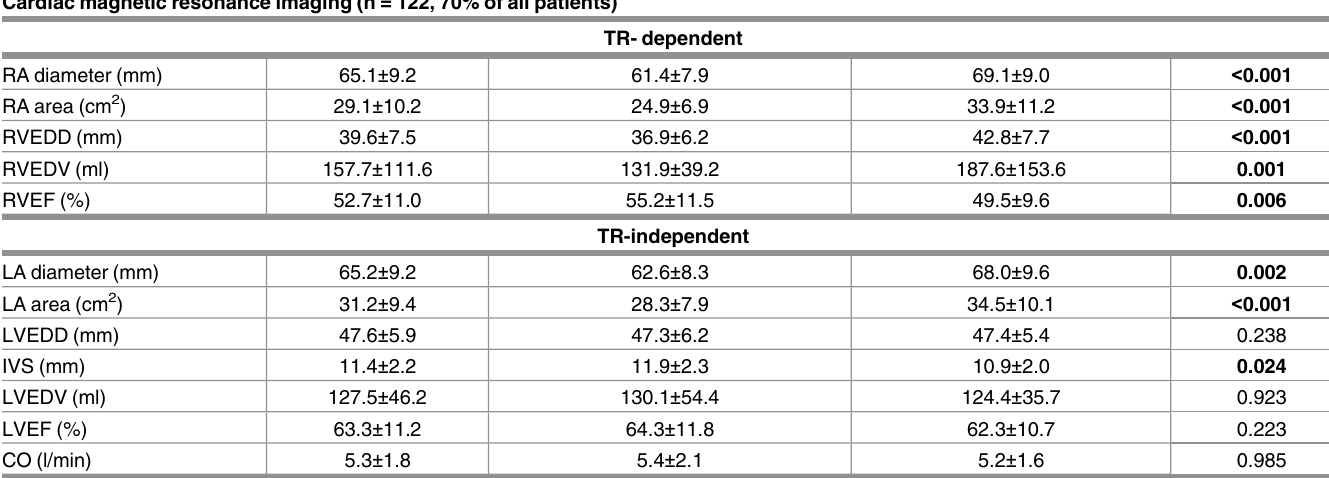
Parameters are listed according to right heart segments versus right heart afterload. Changes in right heart segments are considered consequencesof